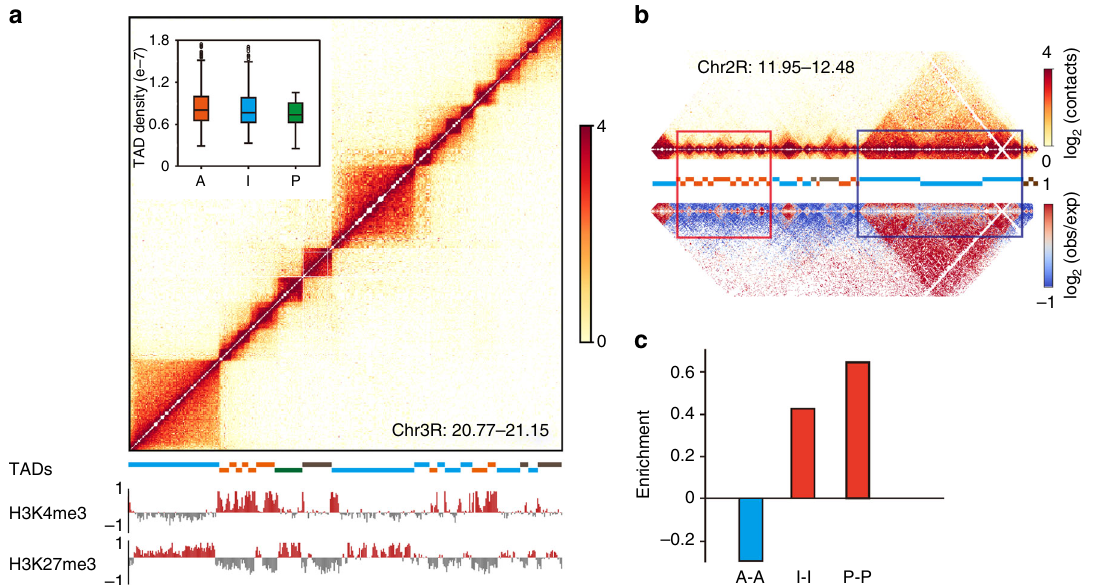
Fig. 3 Epigenetic modi fi cations only correlate with higher-order folding of the TADs but not the folding of individual TADs. a The TADs could be classi fi ed into four major types according to the enrichment of 15 histone modi fi cations and non-histone chromosomal proteins within each TAD (Supplementary Methods). Shown is an example of the distribution of these types with active (orange bar below the heatmap), inactive (blue bar), polycomb (green bar), and undetermined (gray bar) chromatin within the TADs in a 380 kb region of chr3R. Inset: the extent of DNA condensation within the TADs, as determined from the average of contact frequencies between loci within the TAD. b Comparison of the frequency with which active or inactive TADs tend to interact with their immediately neighboring TADs. The upper heatmap shows the positions of the TADs, while the lower heatmap shows the signi fi cance of the observed contacts, with those colored red (blue) exhibiting much greater (lower) interaction strength than expected by chance (Methods) in a 530 kb region of chr2R. c The relative interaction strength (as shown in b ) between pairs of TADs. A active, I inactive, P